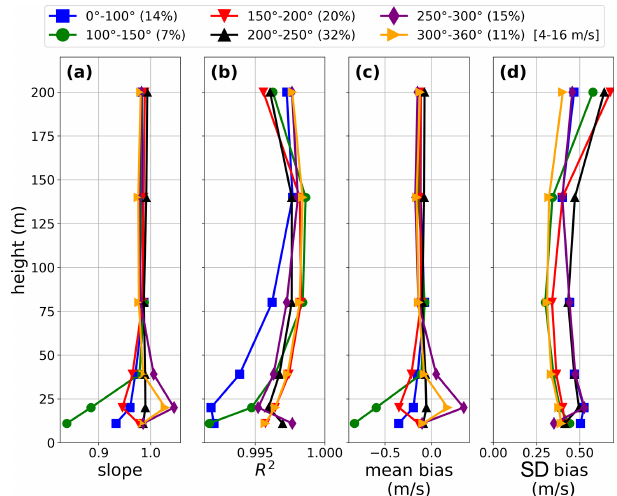
Figure A2. Profiles of linear regression analysis results and bi- ases in the wind speed, applied to different wind sectors, where the wind speed is bounded to the 4–16ms − 1 range. Panels (a, b) show the parameters for a linear regression without offset, and pan- els (c, d) show the mean bias and standard deviation of the bias. The percentages in the legend indicate the occurrences of the differ- ent wind